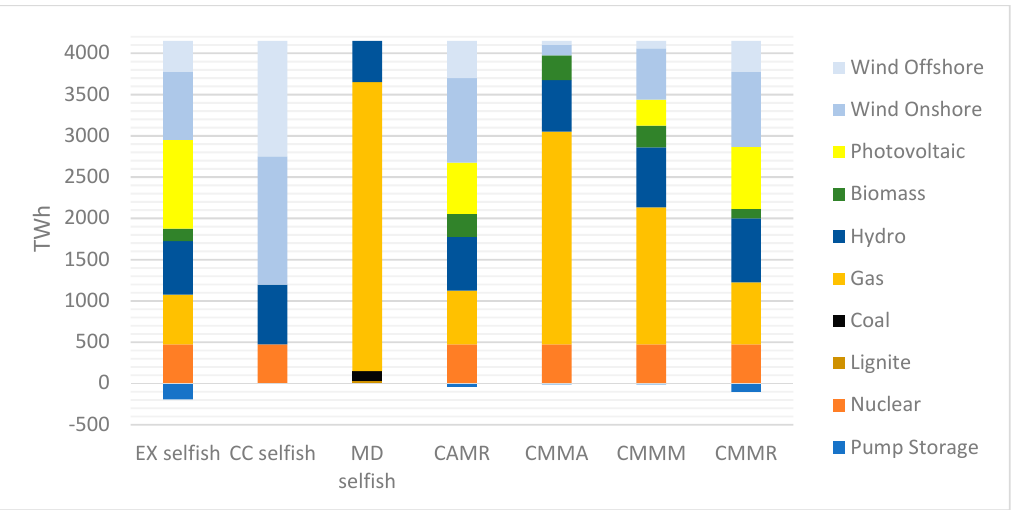
Figure 3. Electricity mix in 2050 of the scenarios with feasible solutions.